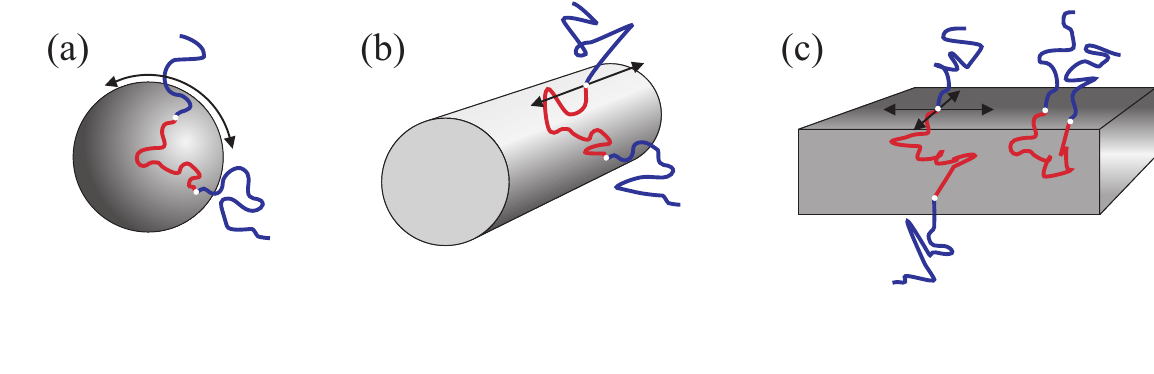
Schematic presentation of possible diffusion displacements of the triblock copolymer chains in micellar ( a ) rod-like cylindrical ( b ) and lamellar ( c ) substructures. The arrows indicate the directions of unrestricted interface